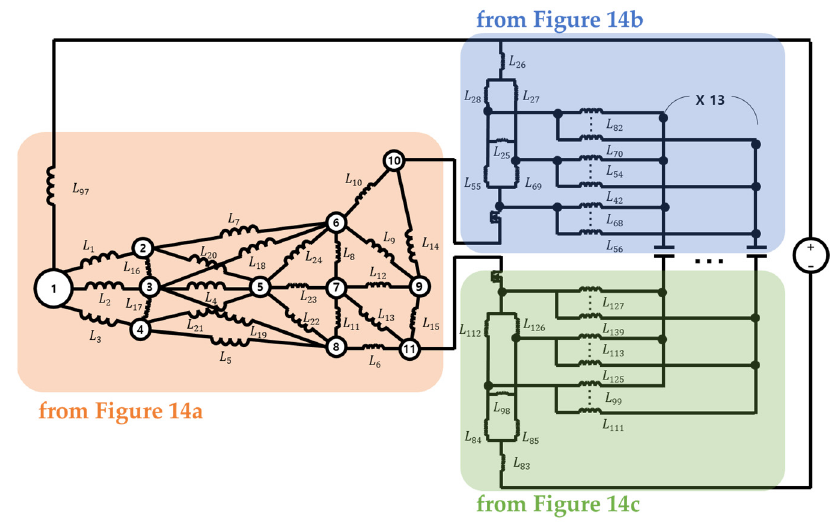
Figure 15. Derived equivalent circuit of DPT circuit.